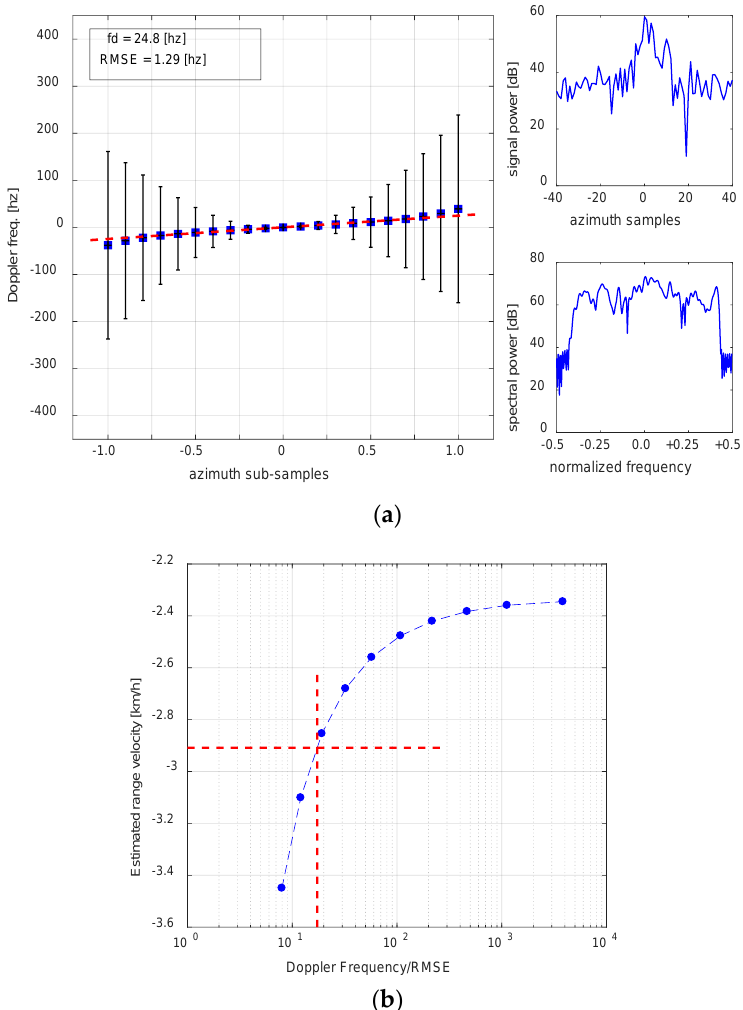
Figure 4. Results from the ship for the experiment denoted by “A’” in Figure 1b. The ship velocity measured by on-board GPS at the time of SAR data acquisition was 16.4 km/h with an azimuth and range component of 16.1 and 2.91 km/h, respectively. The PSLR and SCR are − 6.5 dB and 31.7 dB, respectively. The estimated residual Doppler frequency of 24.8 Hz corresponds to the range of − 2.85 ± 0.15 km/h. From this analysis, the optimum ratio of Doppler frequency to RMSE in the sea is determined as 17.